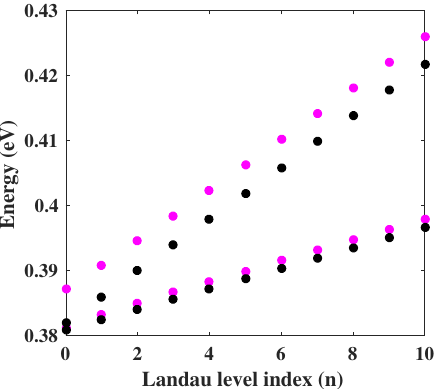
Figure 5. Landau levels in the CB at the Γ point of the BZ as a function of the LL index n for B z = 10 T. Magenta dots indicate LLs which can be obtained from the Ansatz in Equation (16). Black dots show the “conventional” LLs, see the